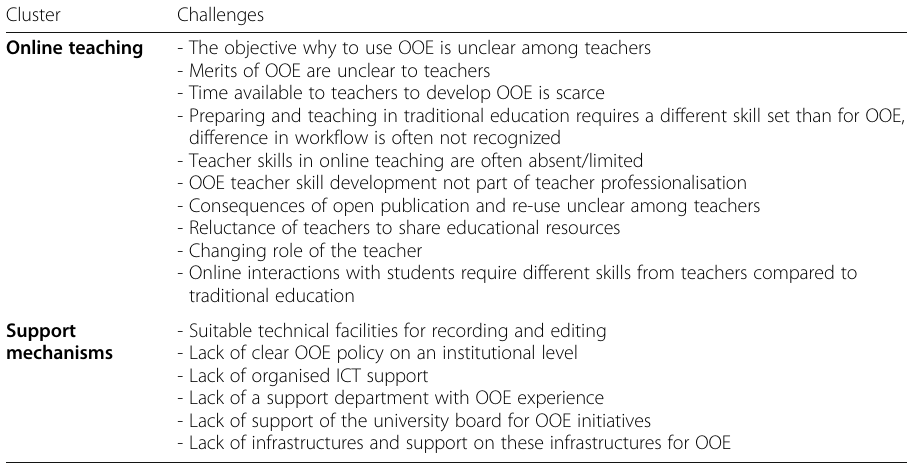
Table 1 Organizational challenges that are experienced as important for success of educational innovation projects (Schophuizen et al.